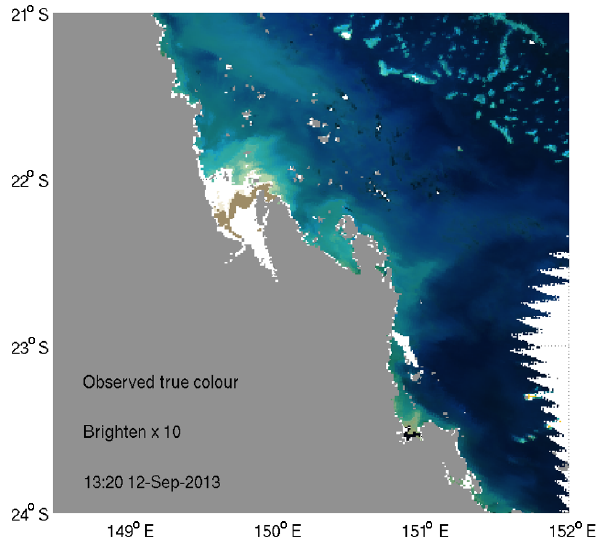
Figure 16. Observed true-colour image on 12 September 2013 obtained from 1km resolution, atmospherically corrected ANN remote-sensing reflectance. The RGB wavelengths used were 667, 551 and 488nm and processed using the MODIS true-colour algo- rithm (Gumley et al., 2010; Baird et al., 2016a). The white pixels are clouds, and grey is land.